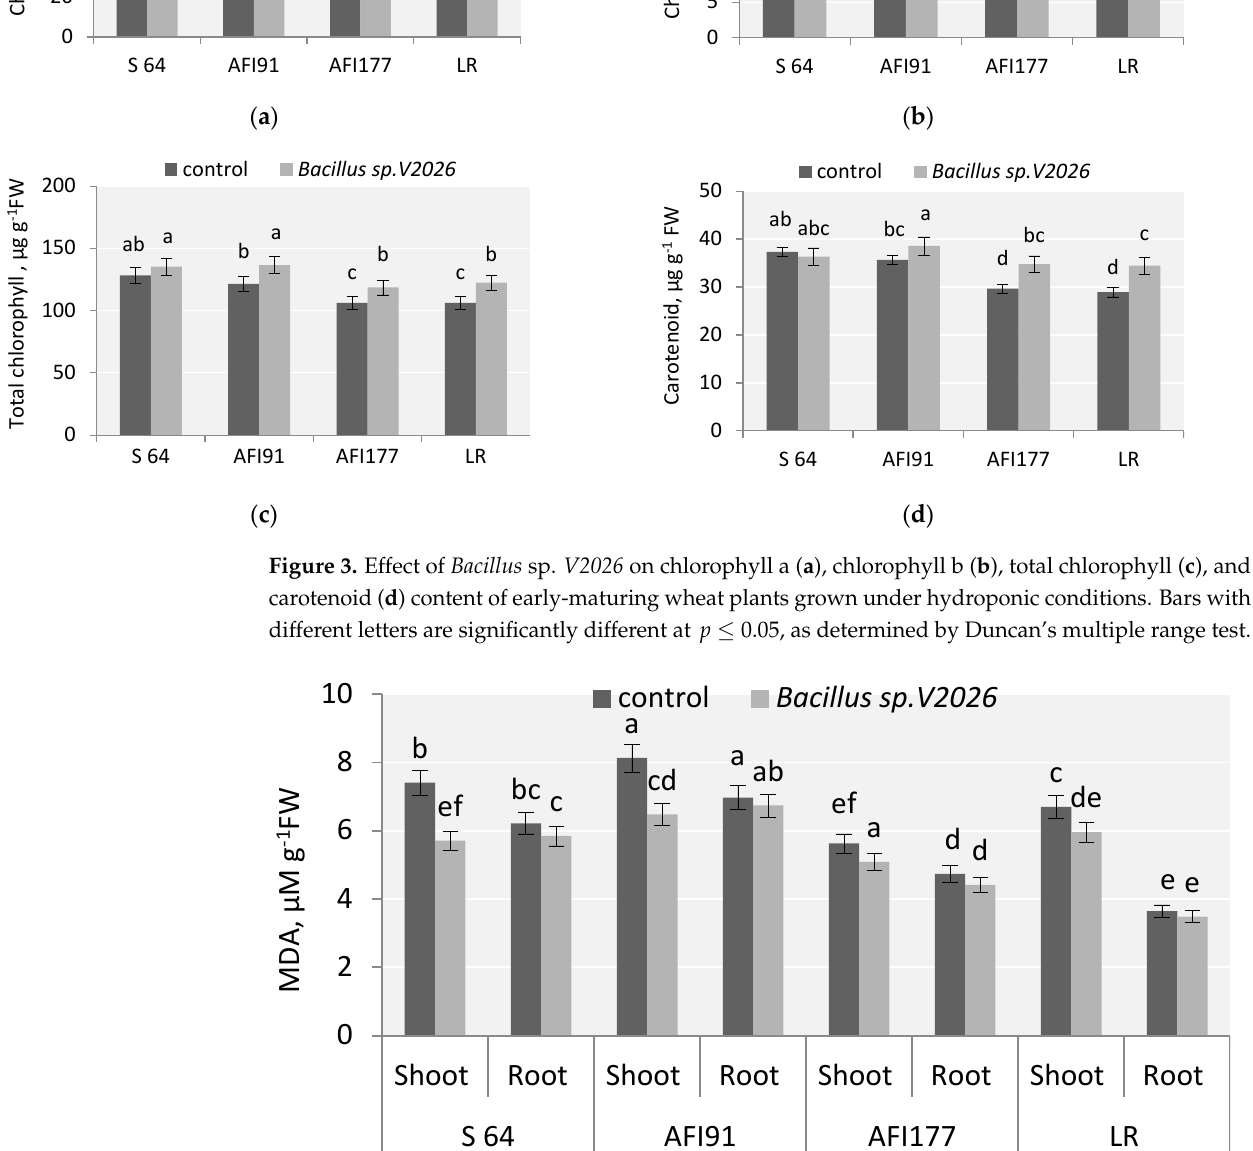
Figure 4. Effect of Bacillus sp. V2026 on malondialdehyde (MDA) content of early-maturing wheat plants grown under hydroponic conditions. Bars with different letters are significantly different at p ≤ 0.05, as determined by Duncan’s multiple range test.